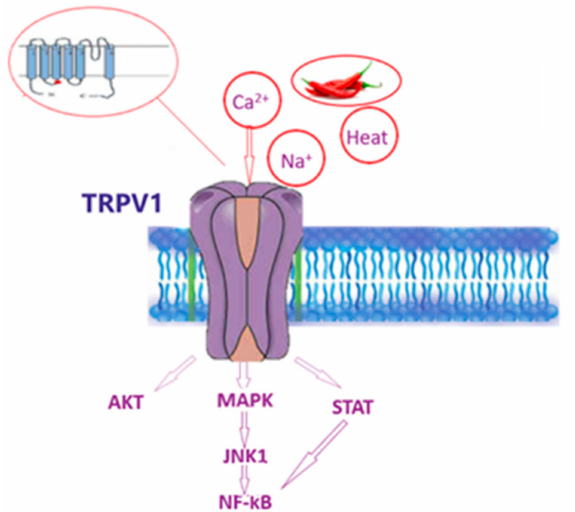
Figure 3. Representation of TRPV1 receptor and the main mechanisms of action. TRPV1 acts on three pathways: Phosphoinositide 3-kinase/protein kinase B (PI3/AKT), Transforming growth factor- β - activated kinase 1/mitogen-activated protein-kinase (TAK1/MAPK), and Janus kinase/signal transducer and activator of transcription (JAK/STAT). In particular, the calcium influx stimulates TRPV1 and improves the activation of several kinases that promote the activation of nuclear factor-kB